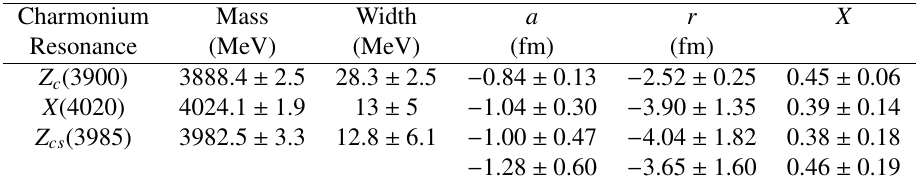
D ∗ 0 or D ∗− D 0 . s s